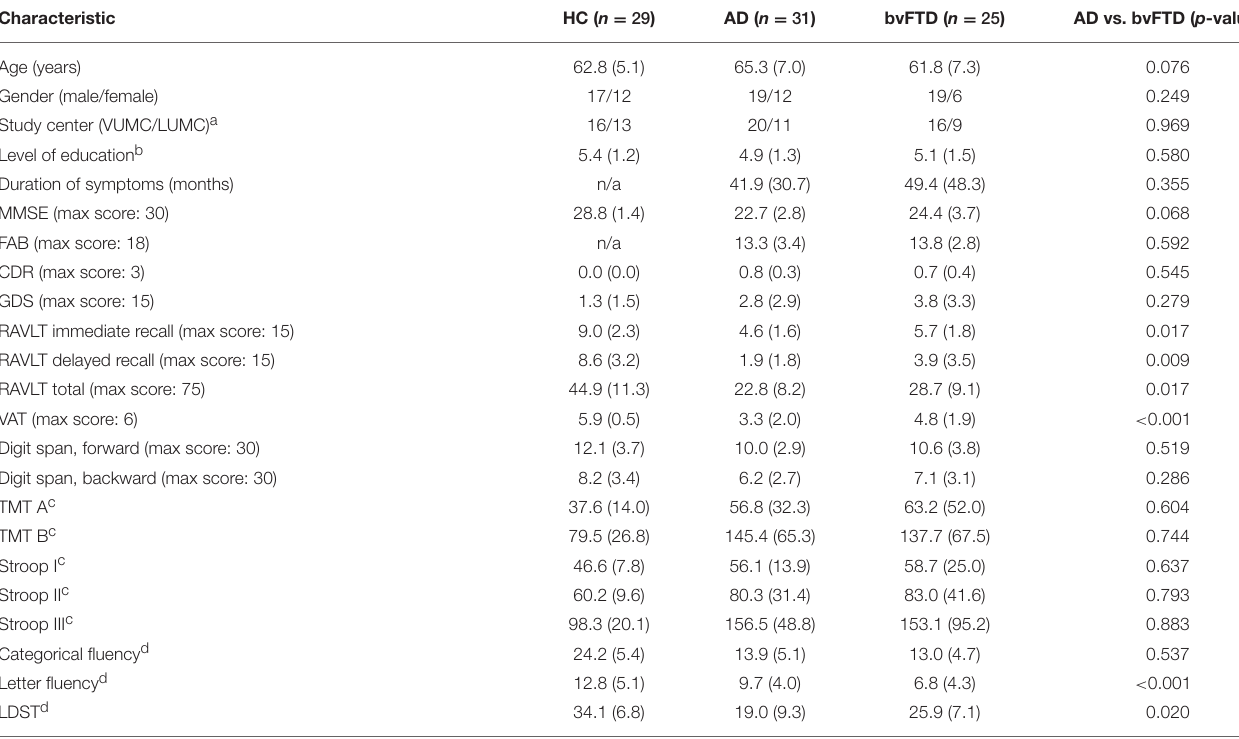
TABLE 1 | Characteristics of the study population.